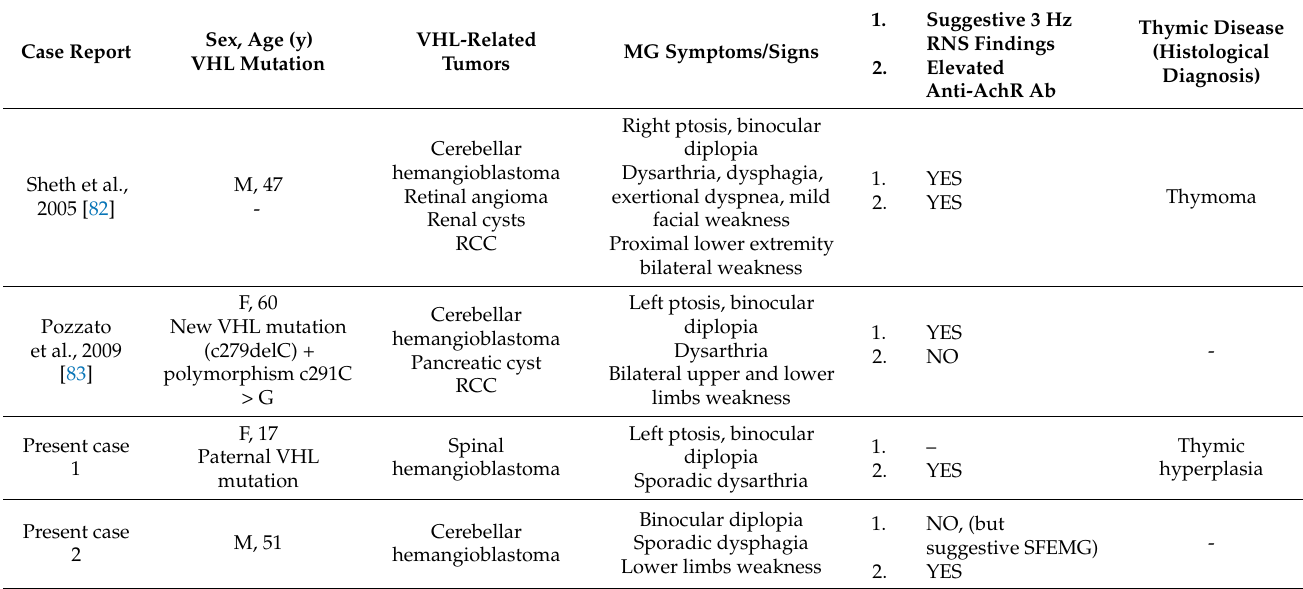
Table 1. Clinical features of patients with VHL disease and